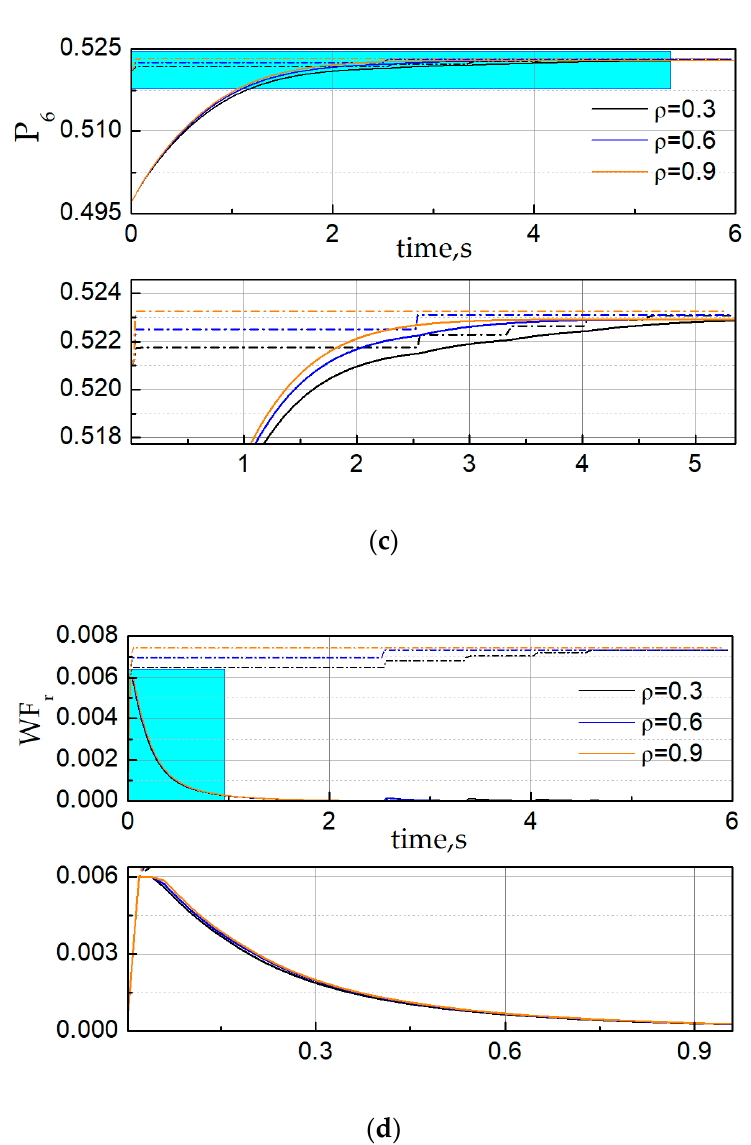
Figure 5. Comparison of RGs with limit governors (LGs) using different parameter values. ( a ) The time history of fan speed (solid line) and admissible reference command (dash dot); ( b ) the time history of the high-pressure turbine outlet temperature (solid line) and corresponding limit (dash dot); ( c ) the time history of the low-pressure compressor outlet pressure (solid line) and corresponding limit (dash dot) and ( d ) the time history of the rate of fuel flow (solid line) and corresponding limit (dash dot).